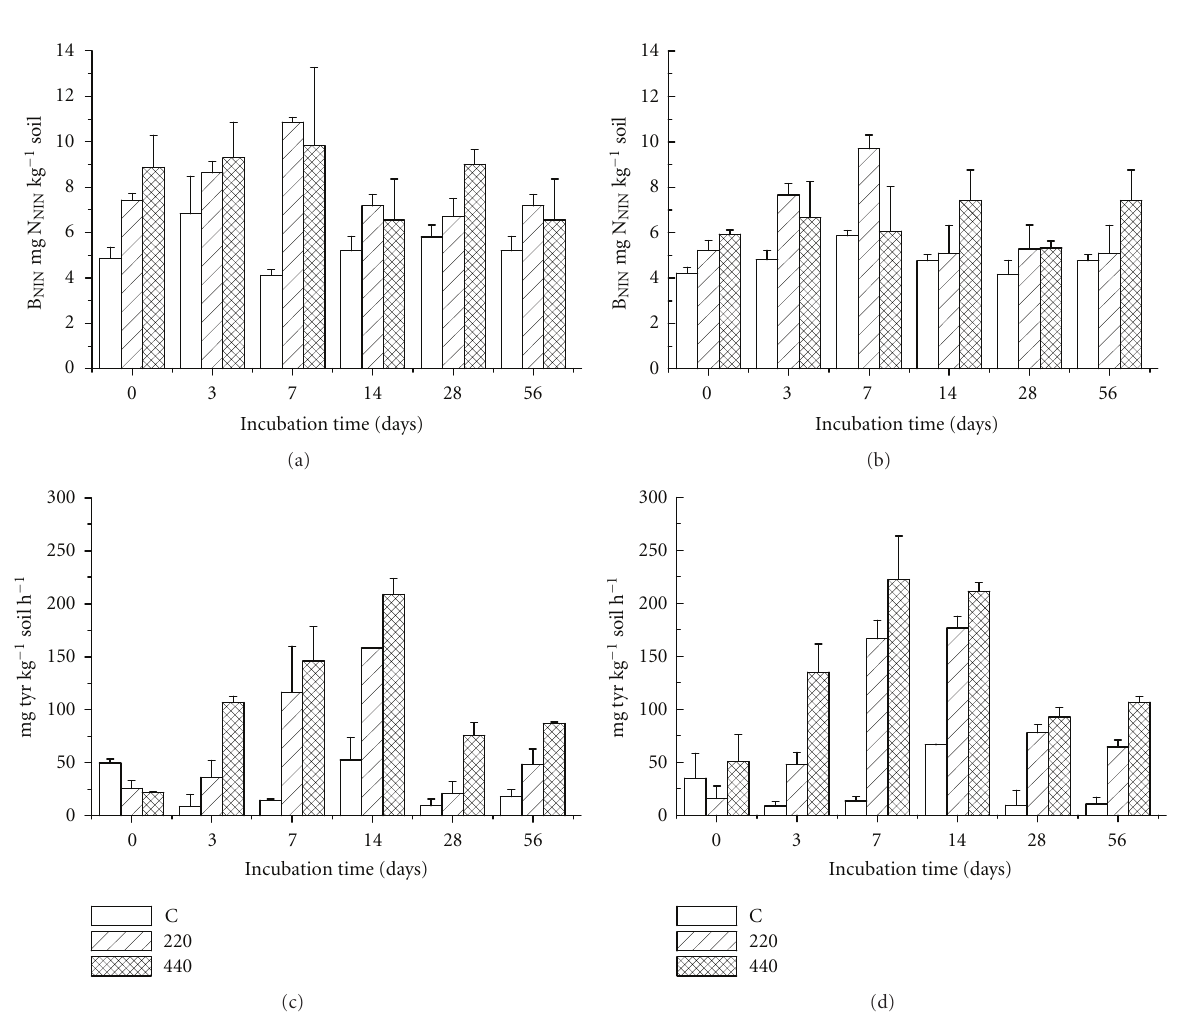
Figure 4: Microbial biomass ninhydrin-reactive N (B NIN ), in soil M (a) and soil P (b) and protease activity in soil M (c) and soil P (d) at di ff erent sampling time. C: controls; P. 220: TLP addition rate at 220 kg Nha − 1 ; 440: TLP addition rate at 440kg Nha − 1 ; bars represent standard deviation ( n =